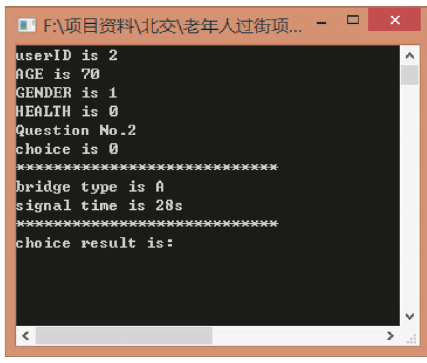
Figure 3: The command line tool that is developed for managing thesurveyandgeneratingquestions(inthescreenshot“A”indicates type I